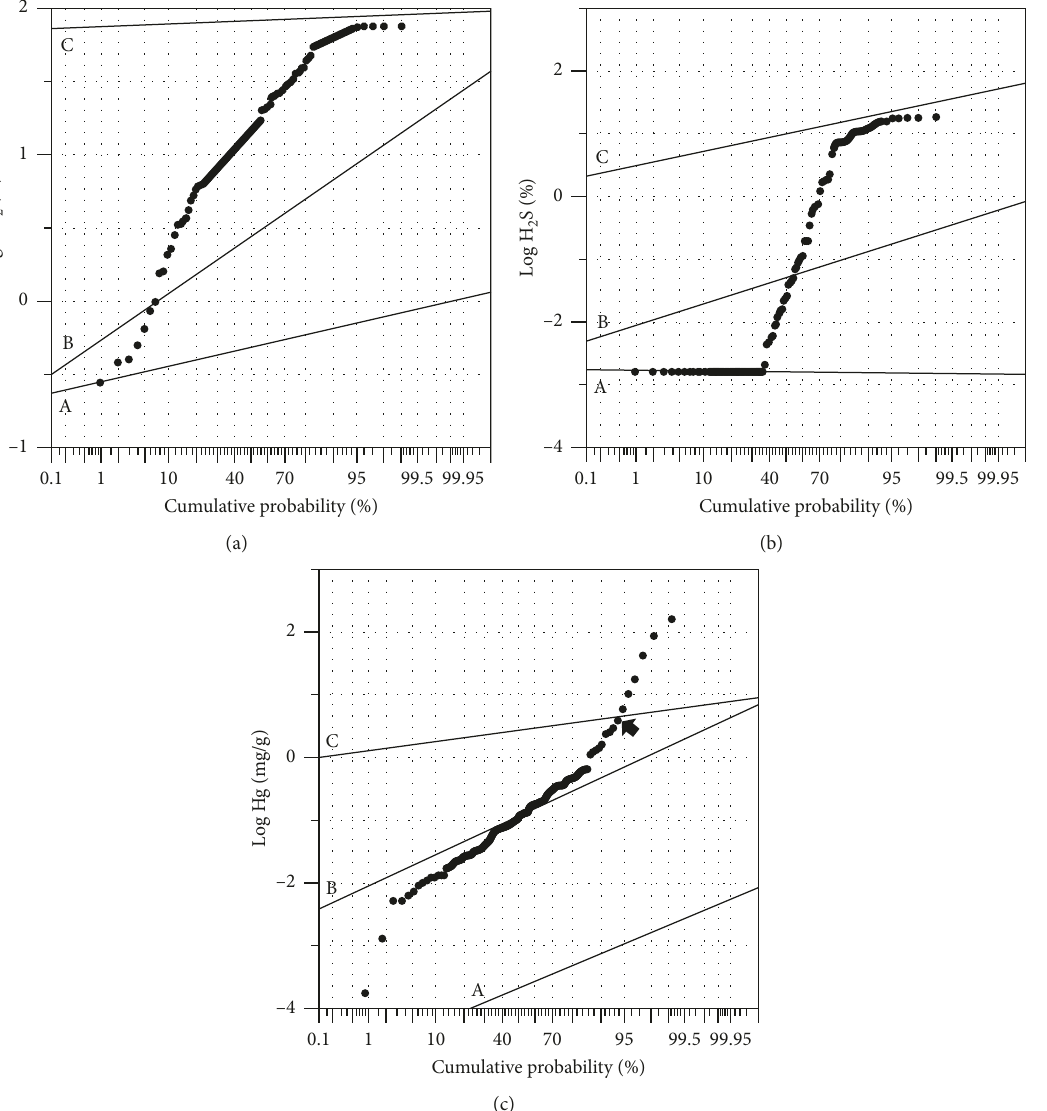
Figure 7: Probability plots of total CO Lakki